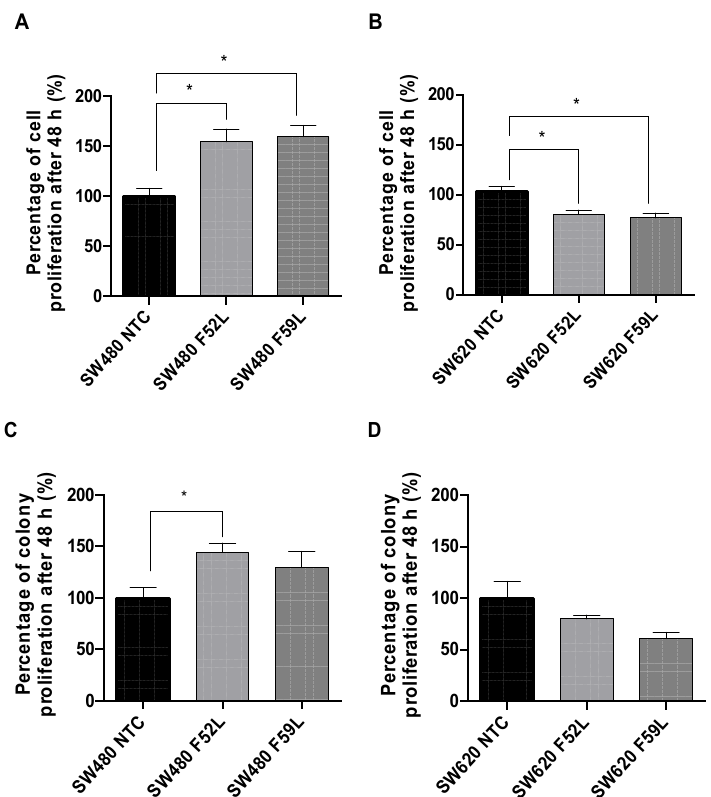
Figure 4. Impact of FUT8 knockdown on the proliferative activity of SW480 and SW620 cell lines. Cell proliferation in ( A , B ) adherent and ( C , D ) non-adherent conditions was measured in SW480 and SW620 NTC clones and their corresponding FUT8- silenced F52L and F59L clones, using alamar Blue assay. To generate non-adherent conditions, the cells were cultured in soft agar. The results are given as a percentage of proliferation, considering the basal point for each cell line (NTC clones) as 100%. The plots represent mean ± SEM of assays performed in triplicate. NTC clones were used as reference for statistical calculations. An unpaired t-test was applied for statistical analysis; * p < 0.05.